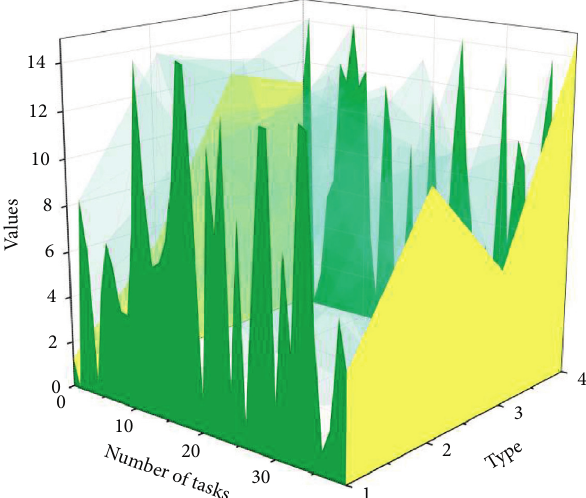
Figure 7: Total task owner satisfaction and average gain underweighting parameter μ � [0.1, 0.6].